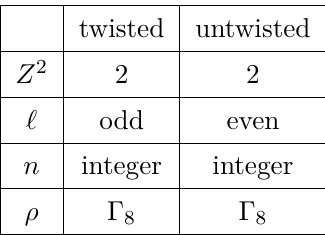
Table 1 . Quantum numbers of the massless states in the twisted and untwisted sector in nine dimensions. The states must satisfy (2.37) to be